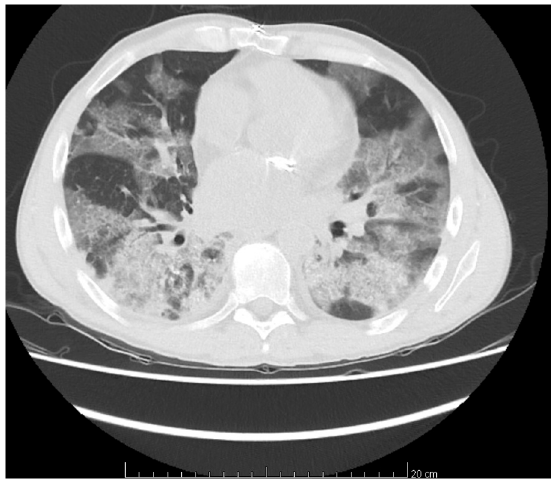
Figure 1. Computer tomography scan revealed wide areas of bilateral ground-glass opacities with segmental areas of crazy paving and local inflammation . segmental areas of crazy paving and local